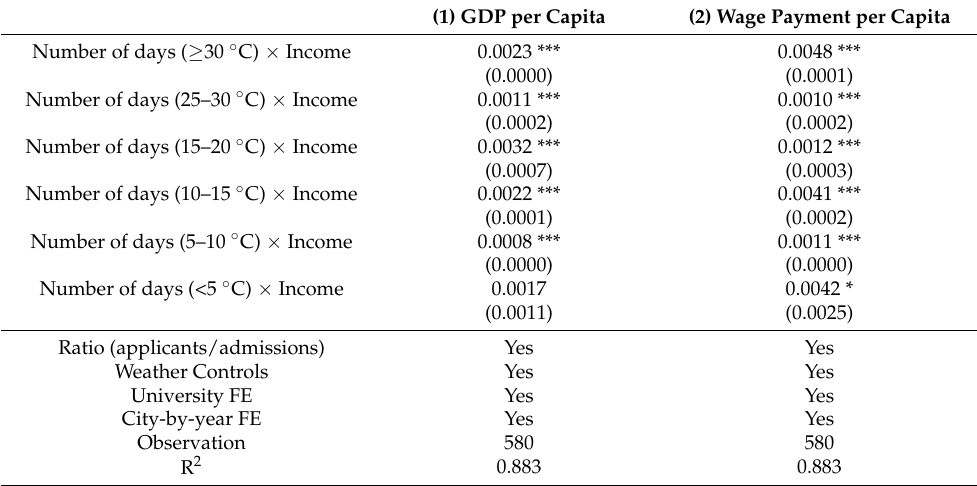
Table 11. Effectiveness of mitigation: